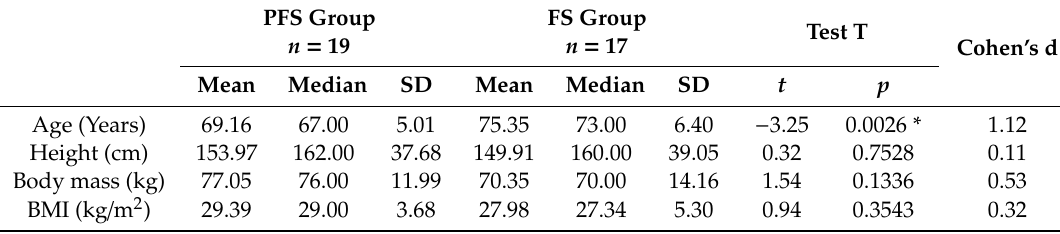
Table 1. Characteristics of the groups.